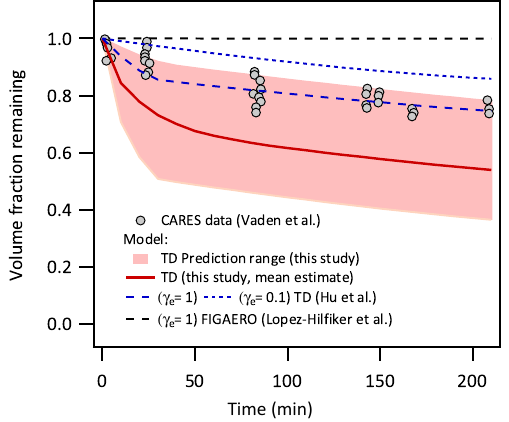
Figure 5. Isothermal evaporation kinetics of OA at 25 ◦ C (room temperature) upon continuous stripping of vapors. Shaded region shows the evaporation kinetic model prediction range applying TD- derived volatility parameter values from this study; solid line shows the mean estimate. Dashed lines show model predictions using the OA volatility distribution derived using alternative approaches dur- ing the Centreville campaign (Hu et al., 2016; Lopez-Hilfiker et al., 2016). Symbols show experimental data from Vaden et al. (2011) collected during the CARES-2010 field campaign in